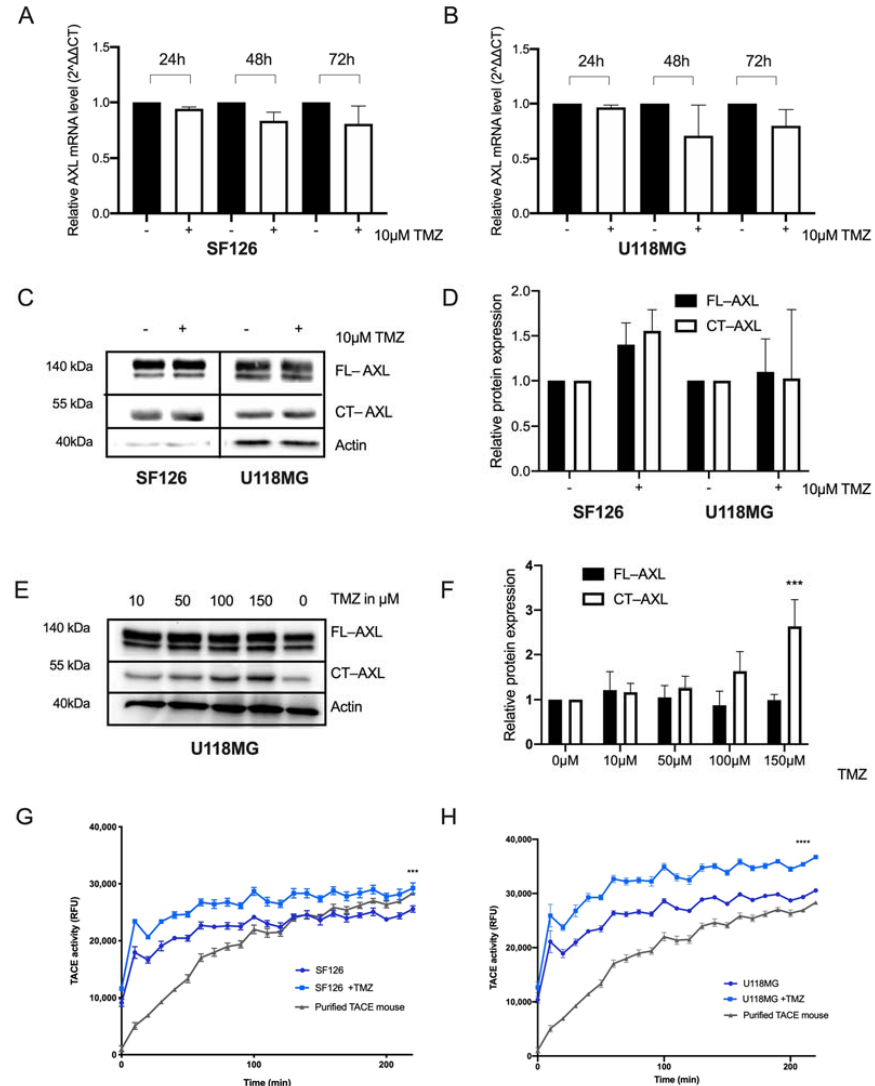
Figure 1. RTK-AXL undergoes post-translational modifications following temozolomide. ( A , B ) Fold gene expression changes in SF126; ( A ) und U118MG; ( B ) cell lines following 10 µ m TMZ exposure at 24, 48 and 72 h ( p = not significant); ( C ) Western blot with lysates of SF126 and U118MG cell lines treated with 10 µ M TMZ for 48 h displaying full length RTK-AXL (FL-AXL) at 140 kDa and C-terminal RTK-AXL (CT-AXL) at 55 kDa; ( D ) Quantitative analysis of relative protein expression of FL-AXL and CT-AXL normalized to beta actin ( p = not significant); ( E ) Effect of increasing doses of Temozolomide (TMZ) and repeated exposures ( n = 5) on protein expression of FL-AXL and CT- AXL expression in U118MG (Western blot) and quantification of protein expression of FL-AXL and CT-AXL expression in U118MG. Ordinary one-way ANOVA, **** p < 0.0001 ( F ). ( G ) Activity of the TACE matrix metalloproteinase ADAM 10/17 following TMZ treatment in SF126 (ordinary one-way ANOVA, *** p < 0.005) und U118MG (ordinary one-way ANOVA, **** p < 0.0001) ( H